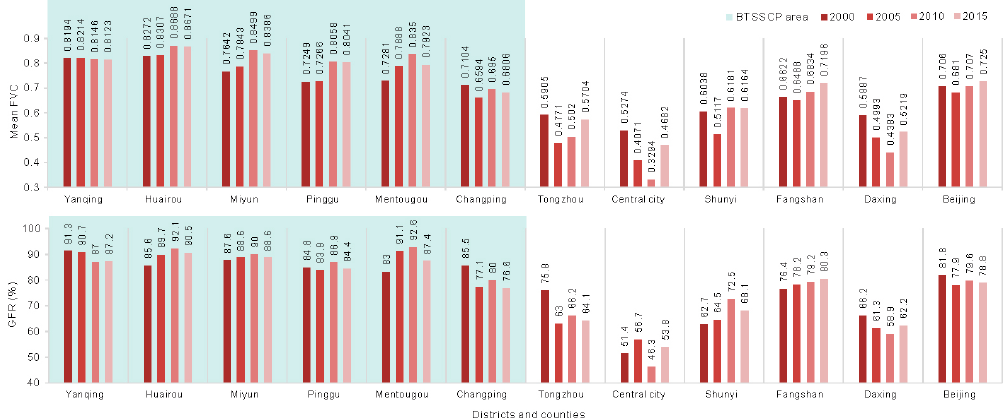
Figure 6. Temporal variations of GFR and mean FVC at district and county levels from 2000–2015. The areas with a blue-green background color belong to the BTSSCP area.